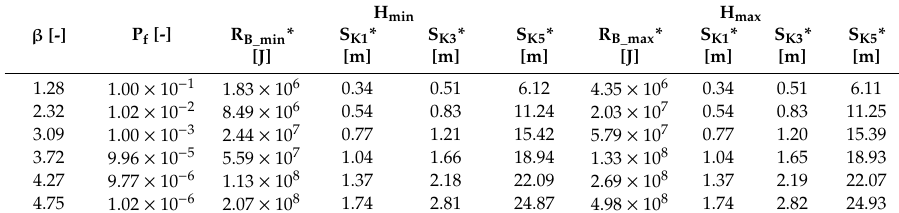
Table 4. Design parameters evaluated for a reliability-based design approach as a function of reliability index values proposed in EN 1990 Annex C Table C1 considering both the maximum and minimum